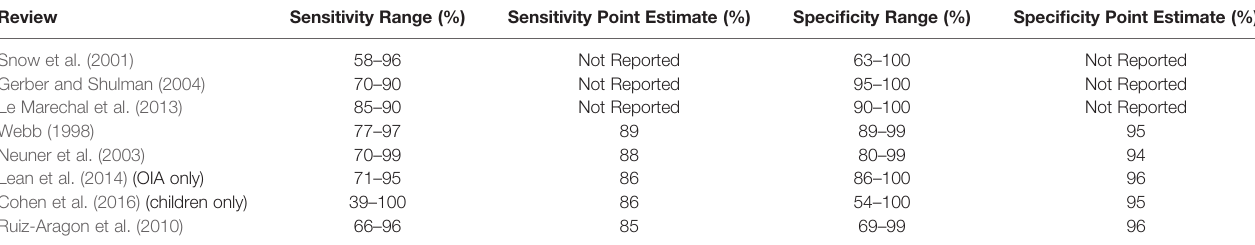
TABLE 3 | Sensitivity and Speci fi city Ranges and Point Estimates for RADTs Reported in Select Review Studies.